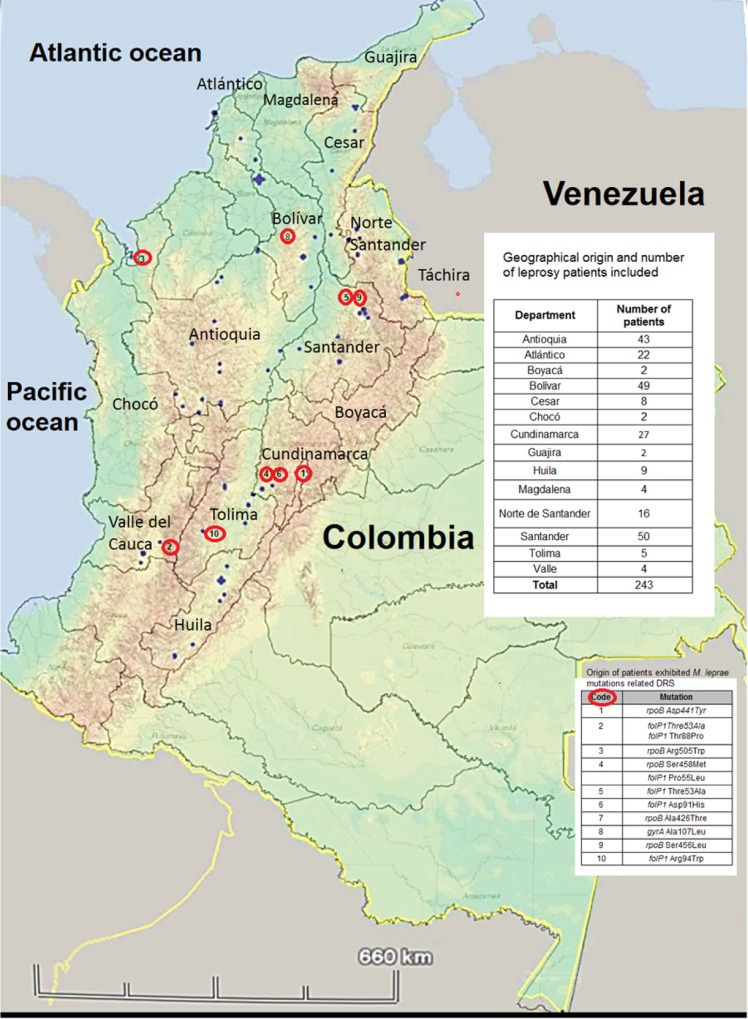
Geographical origin of leprosy patients that exhibits M. leprae drug resistance related mutations.